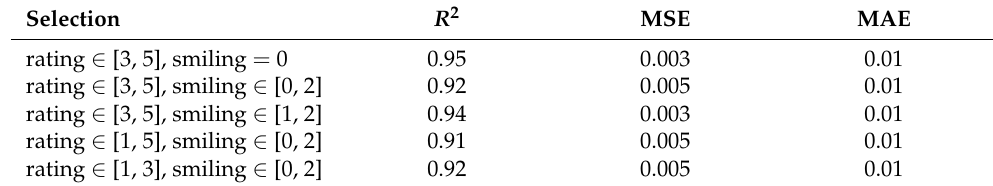
Table 7. The impact of participant’s behavior on prediction accuracy for Decision Tree